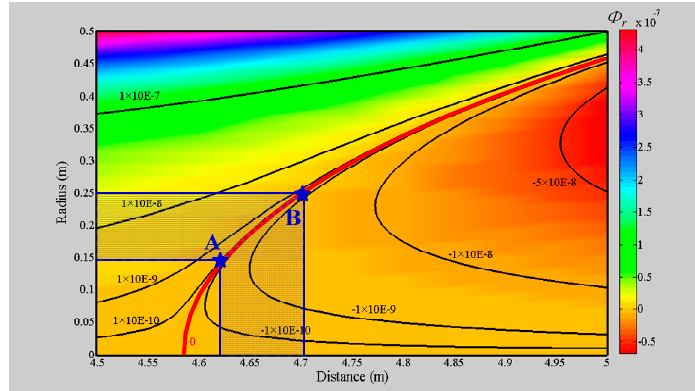
Figure 6. Contour map of the magnetic flux Φ r versus D TR and the circle radius R acc .